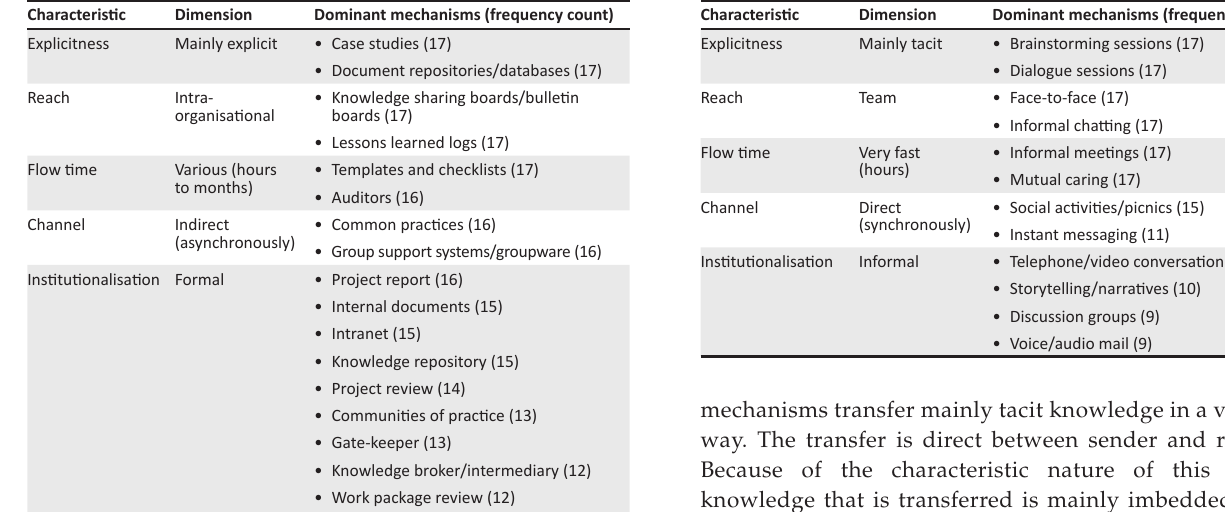
TABLE 12: Cluster 3 main characteristics and dominant knowledge transfer mechanisms.